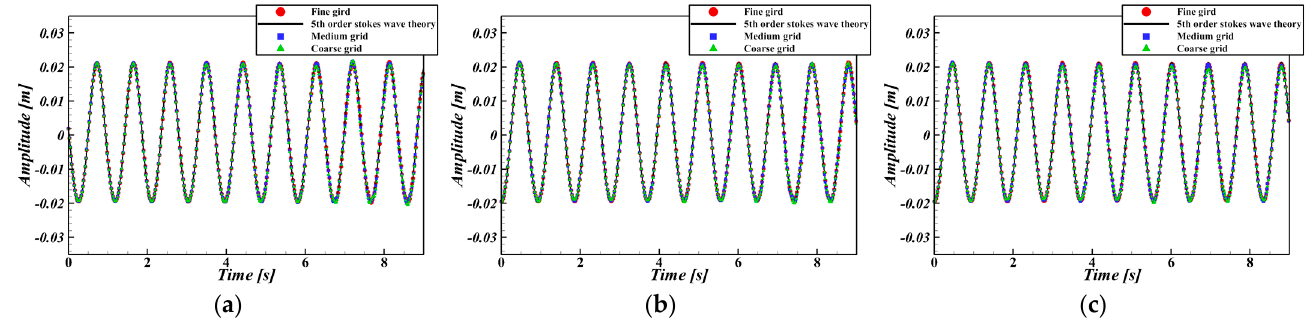
Figure 11. Comparison of wave profiles at 𝛌 = 1.350 m: ( a ) 𝒙 (cid:3404) (cid:3397)1.650 m from the origin; ( b ) 𝒙 (cid:3404) (cid:3397)0.675 m from the origin; ( c ) 𝒙 (cid:3404) (cid:3398)0.675 𝑚 from the origin.